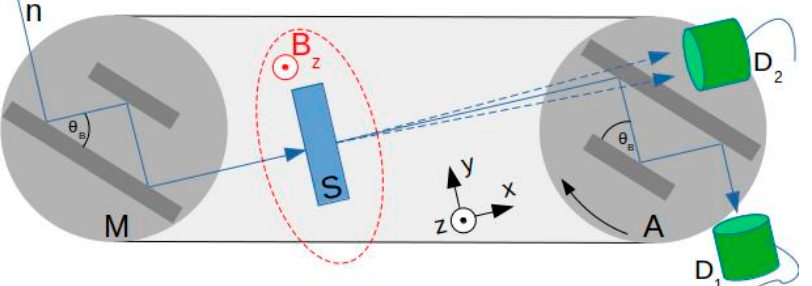
Figure 1. USANS setup (not to scale): so-called Bonse-Hart camera configuration with channel-cut silicon perfect crystals (monochromator M and analyzer A, lattice planes are parallel to the crystal slab faces), sample S in a region with an applied vertical, static magnetic field B z , and detectors D 1 and D 2 [29].